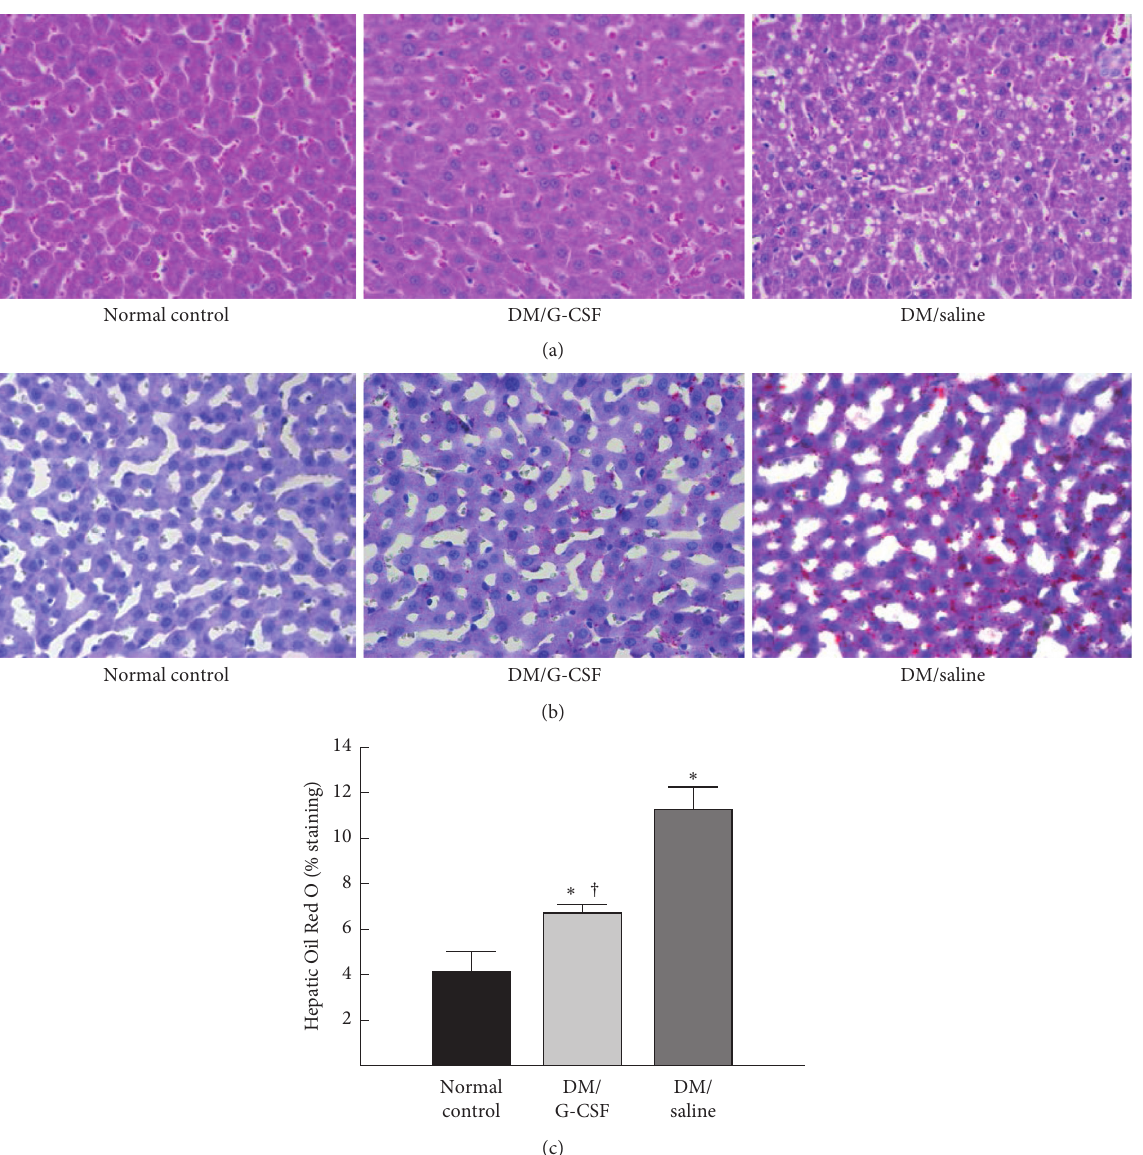
Figure 3: Histological changes in the liver . (a) Representative images of hematoxylin and eosin (H&E) staining in the liver sections from each treatment group (magnification × 400). (b) Liver sections were stained with Oil Red O (magnification × 400). (c) Quantitative analysis was conducted in Oil Red O-stained sections, and the mean area (%) occupied by Oil Red O-positive area was calculated for five randomly selected fields of each tissue section. DM, diabetes mellitus. All data are expressed as the means ± standard errors ( n � 8 per group). ∗ P < 0 . 05 vs. normal control. † P < 0 . 05 vs.